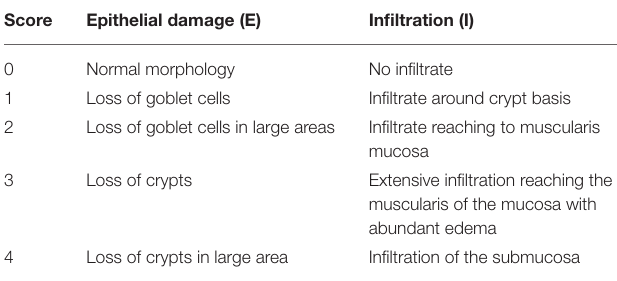
TABLE 1 | Histological scoring using Ito et al.